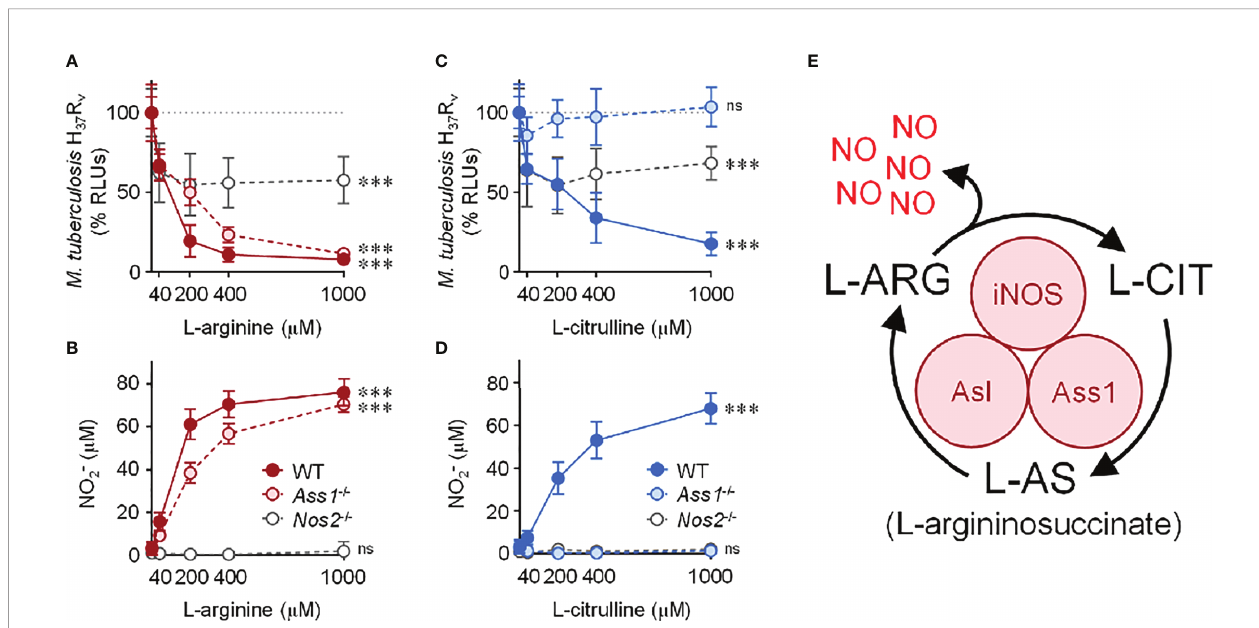
FIGURE 1 | Contribution of L-arginine on anti-tuberculosis macrophage activity in the absence of nitric oxide. (A – D) WT (C57Bl/6 background), Ass1 -/- , or Nos2 -/- PM F s were infected with Mtb H 37 R v (MOI~1) plus IFN- g and cultured in R-free C-DMEM containing titrating amounts of L-arginine (red, A, B) or L-citrulline (blue, C, D). (A, C) RLUs were determined by measuring luminescence 72 hours post-infection and are normalized to 100% Mtb in macrophages without L-arginine or L- citrulline, represented by the dotted line. (B, D) Nitric oxide was evaluated by measuring nitrite (NO − 2 ) concentration by Griess (N ≥ 9, at least three experiments combined). ***p < 0.001 by 1-way analysis of variance (ANOVA) to determine an effect of L-arginine/L-citrulline on RLUs or NO − 2 production; ns, not signi fi cant. Error bars, SD. (E) Schematic of nitric oxide (NO) production and L-arginine (L-ARG) biosynthesis from L-citrulline (L-CIT) in macrophages. iNOS, inducible nitric